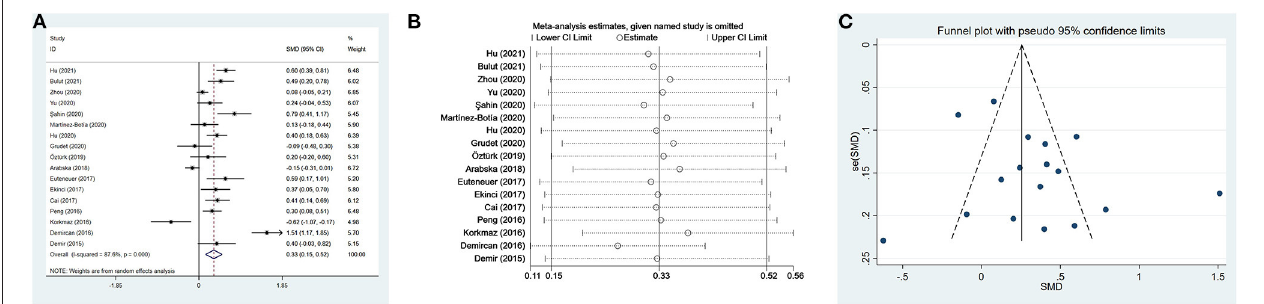
FIGURE 2 | Results of meta-analysis on NLR between depressed patients and controls. (A) Forest plot of standardized mean difference in NLR between depressed patients and controls. Depressed patients showed significantly higher NLR values than controls (SMD = 0.33, 95% CI: 0.15–0.52, p < 0.001). The random-effects model was used due to substantial heterogeneity across studies ( I 2 = 87.6%, p < 0.001). (B) Sensitivity analysis revealed that the SMD values were relatively stable in the direction and significance of the results. (C) The funnel plot was roughly symmetric, which indicated the absence of publication bias in studies evaluating NLR values in